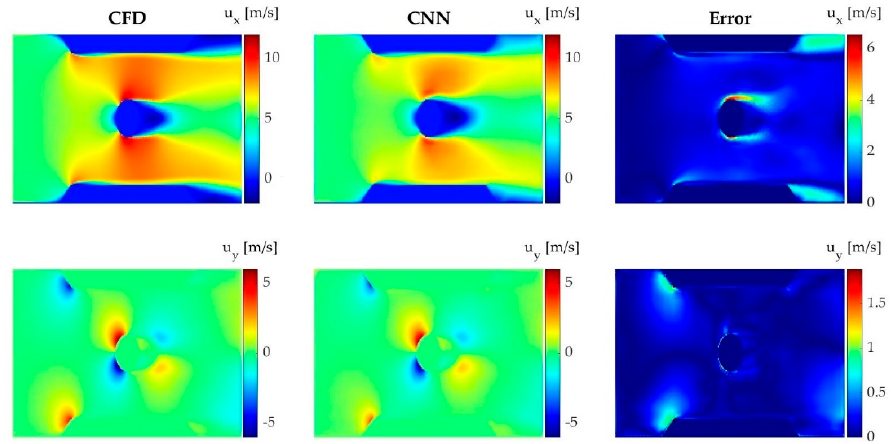
Figure 14. Comparison of the velocity fields of a domain with a different channel obtained with CFD and the proposed net.